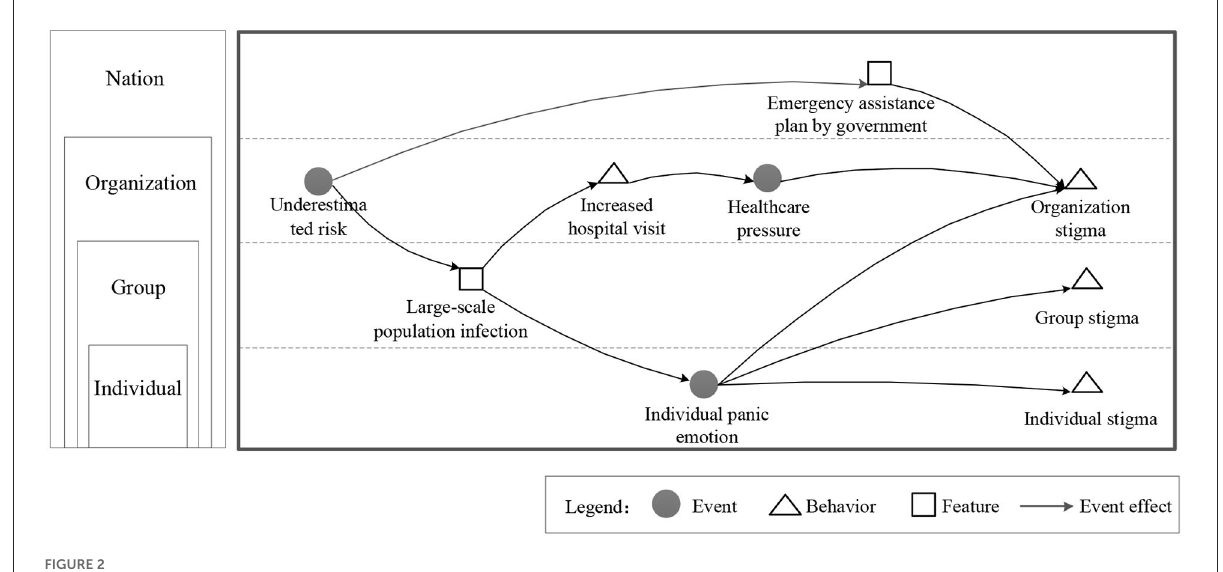
FIGURE2 Diffusion effect of events on entities at different